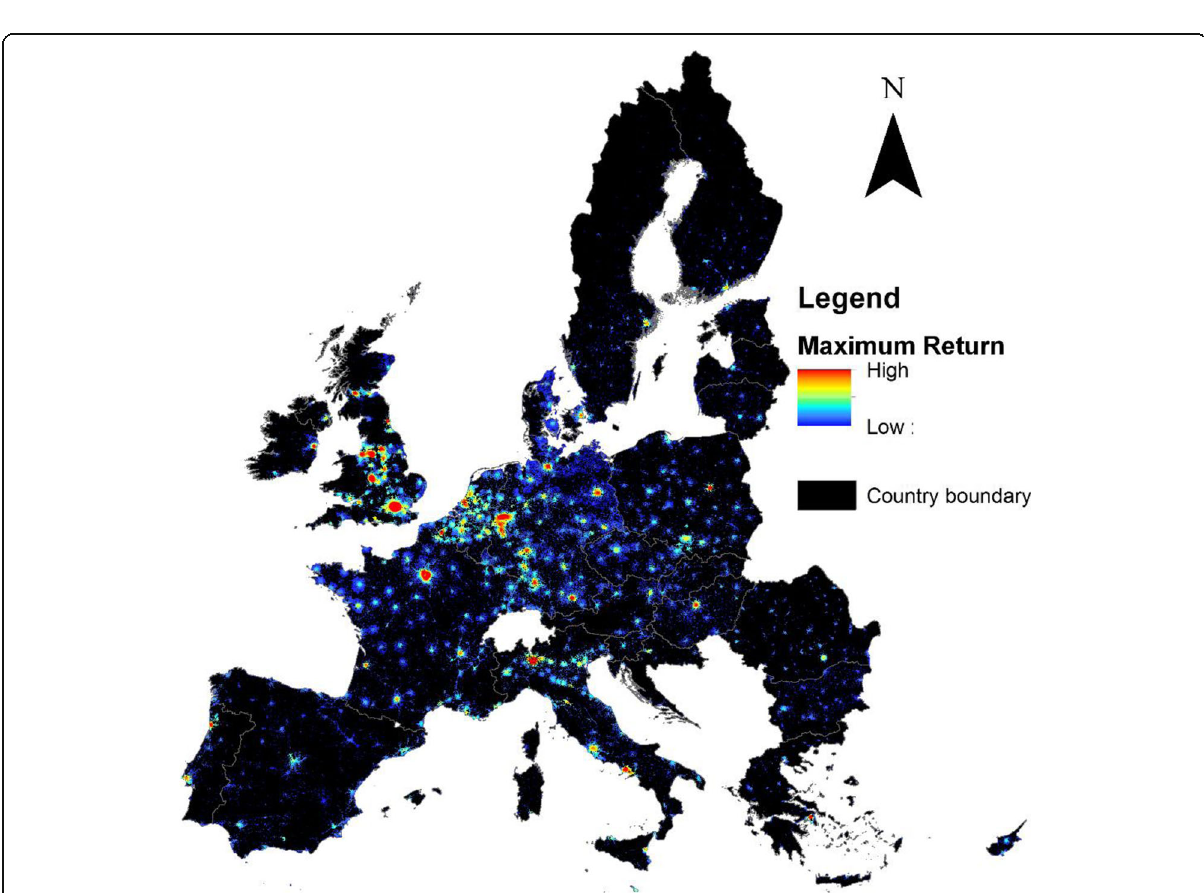
Fig. 5 Return map for the EU28: maximum potential return associated with cells of industrial